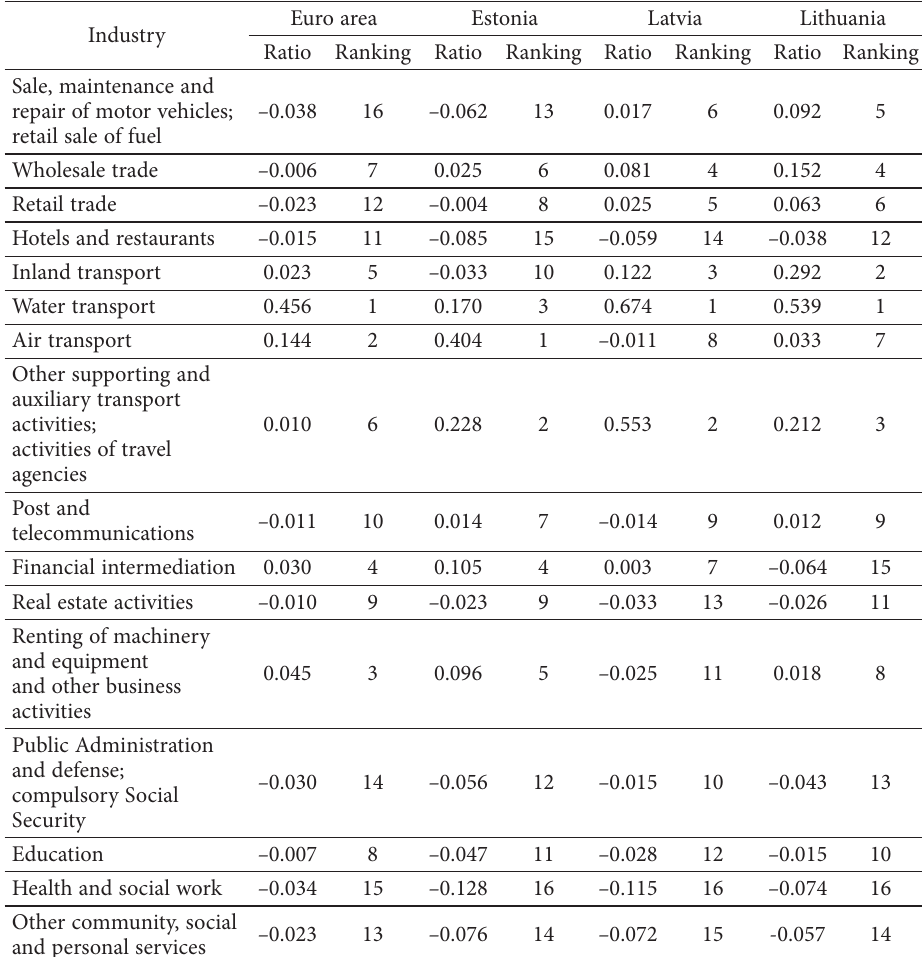
Table 5. Service content ranking in the Euro area and the Baltic States, 2011 Euro area Industry Ratio Ranking Ratio Ranking Ratio Ranking Ratio